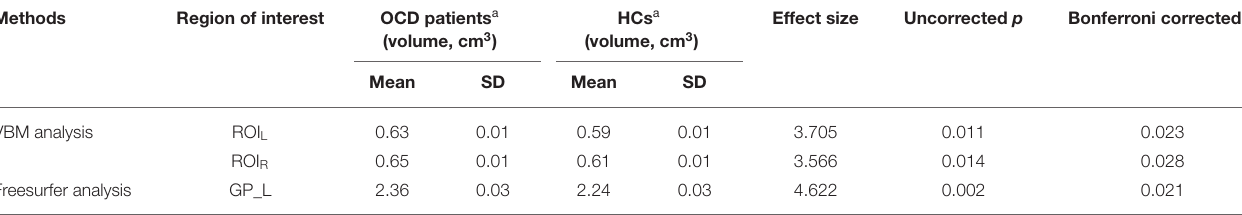
TABLE 5 | Effect size of regions with significant volumetric variation.